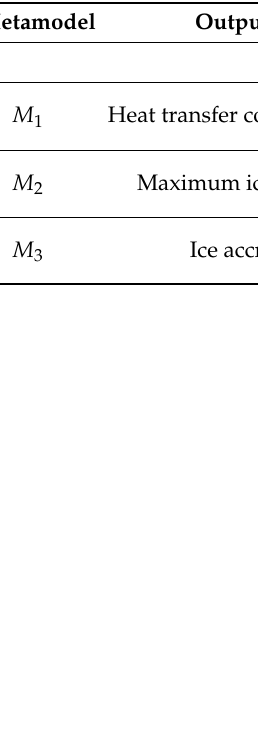
Table 5. Output PDF for each NIPCE prediction on the 10,000 sample